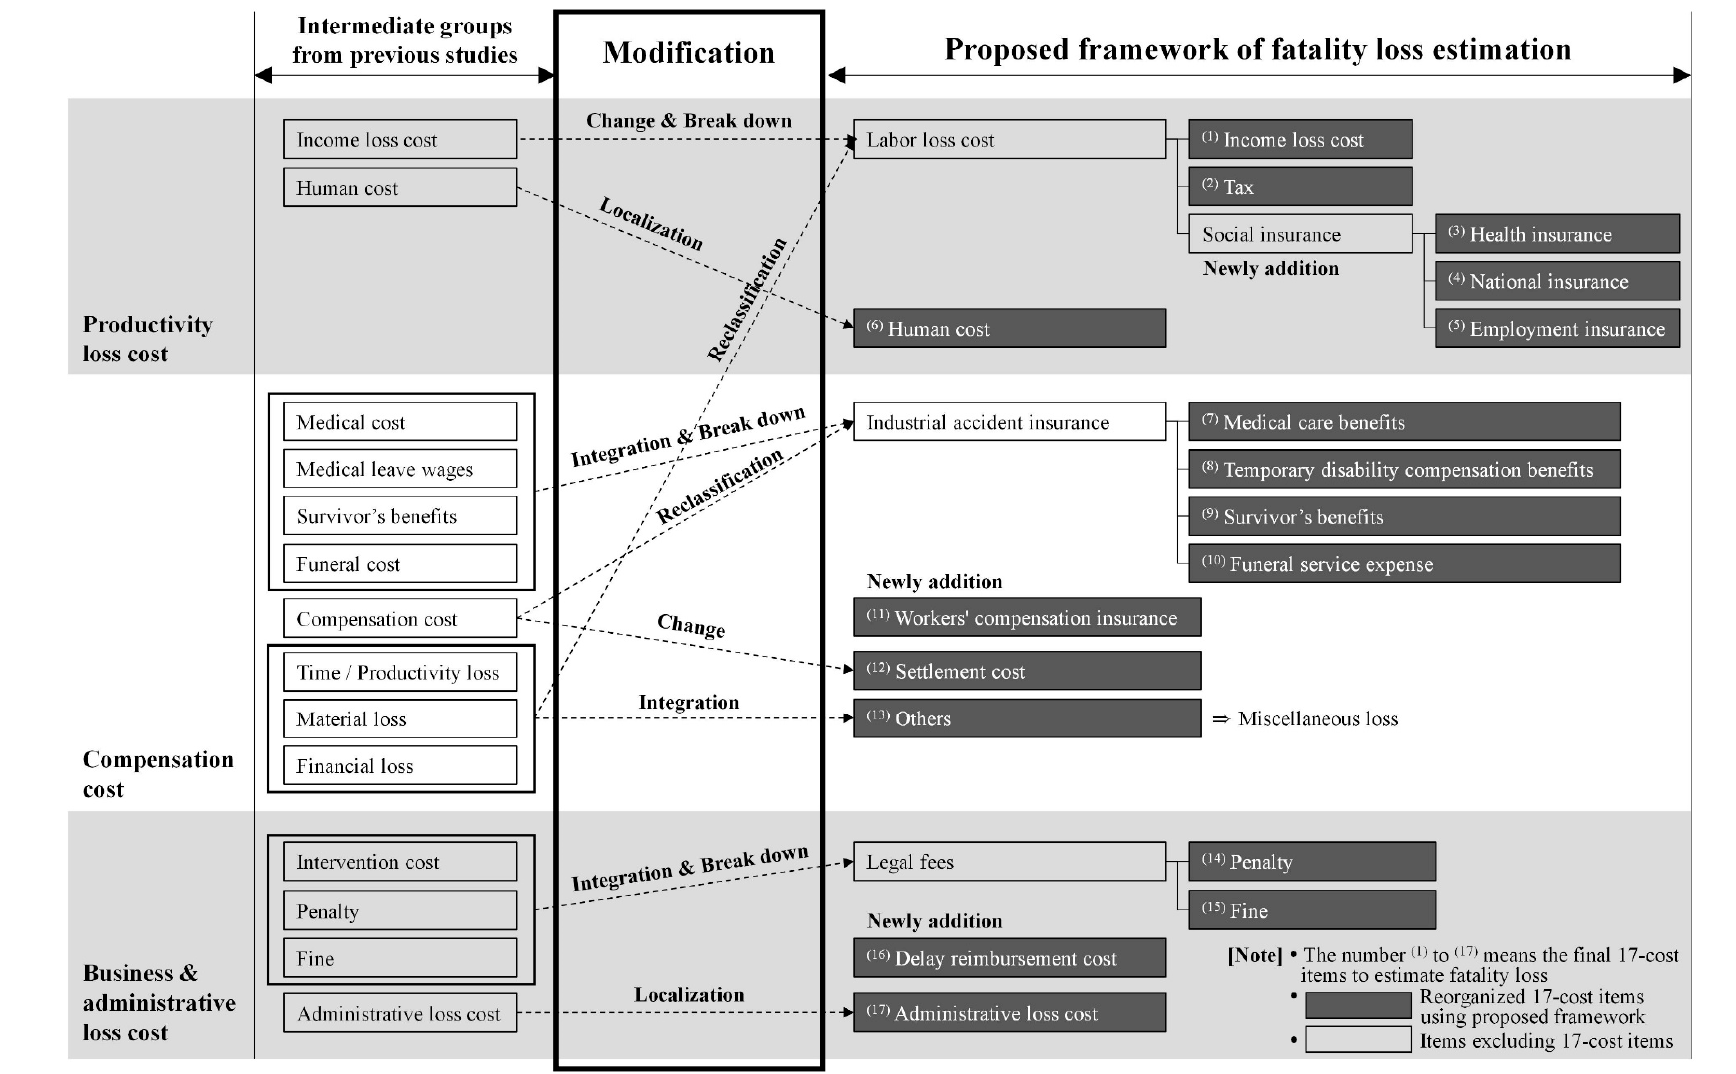
Figure 2. The proposed framework for fatality loss estimation.